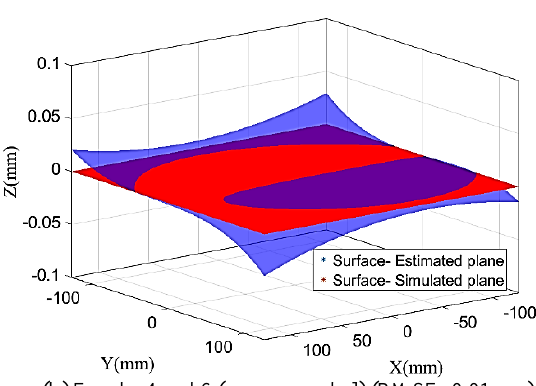
Figure 5. Surface display of simulated and estimated object space